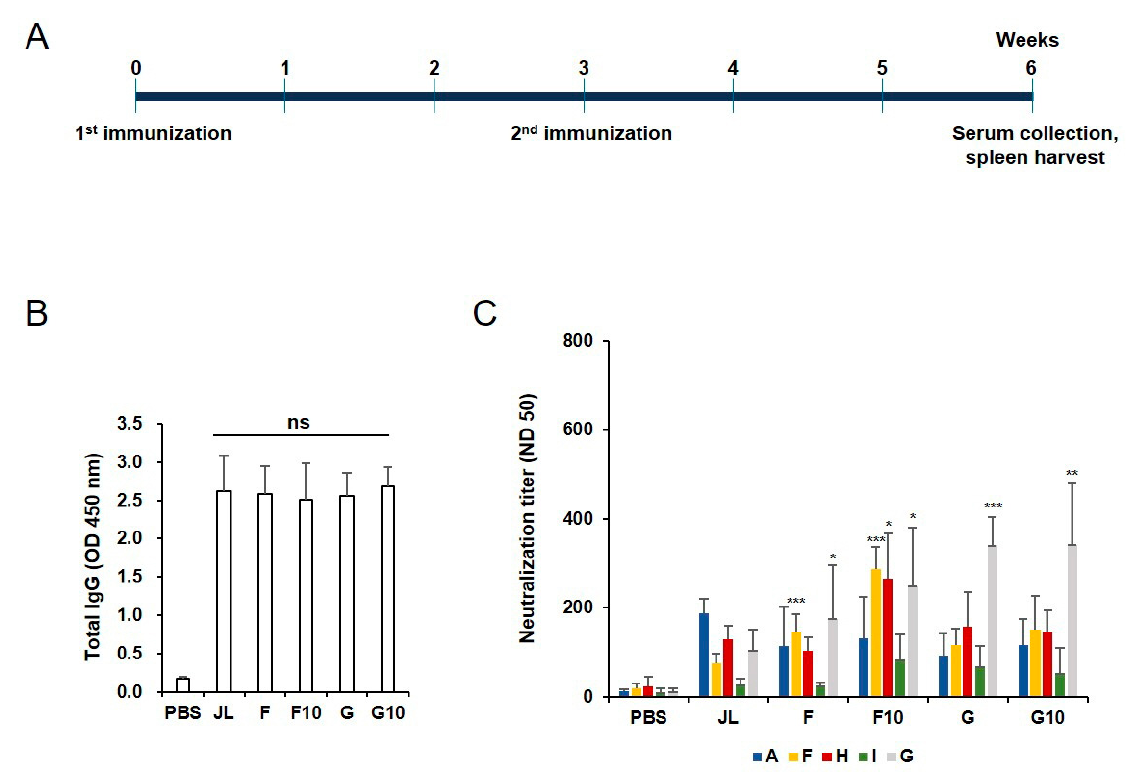
Figure 1. Administration schedule of inactivated mumps vaccine candidates and humoral responses of inactivated mumps vaccine candidates. ( A ) Experimental groups. BALB/c mice were immunized intramuscularly with 10 μ g of inactivated mumps vaccine candidates (F10 and G10), 2.5 × 10 5 ffu/mL of F, G genotypes of MuV, which is the wild-type virus control, and the Jeryl Lynn vaccine (genotype A) which is a positive control and a currently available vaccine at weeks 0 and 3. The blood samples and spleens were collected at week 6. ( B ) Total IgG elicited in BALB/c mice serum among different immune groups measured using ELISA. All vaccinated mice induced a significant MuV-specific IgG response. Not significant (NS) when compared between immunized groups. ( C ) Serum neutralizing antibody responses against diverse genotypes of MuV. Data are presented as the mean ± SD pooled from triplicate experiments (N = 5). Neutralizing antibodies against the F, H, and G MuV genotypes were significantly higher in the F10 immunized group (n = 5) compared to the JL immunized group. * p < 0.05, ** p < 0.01, *** p < 0.005 analyzed by unpaired t